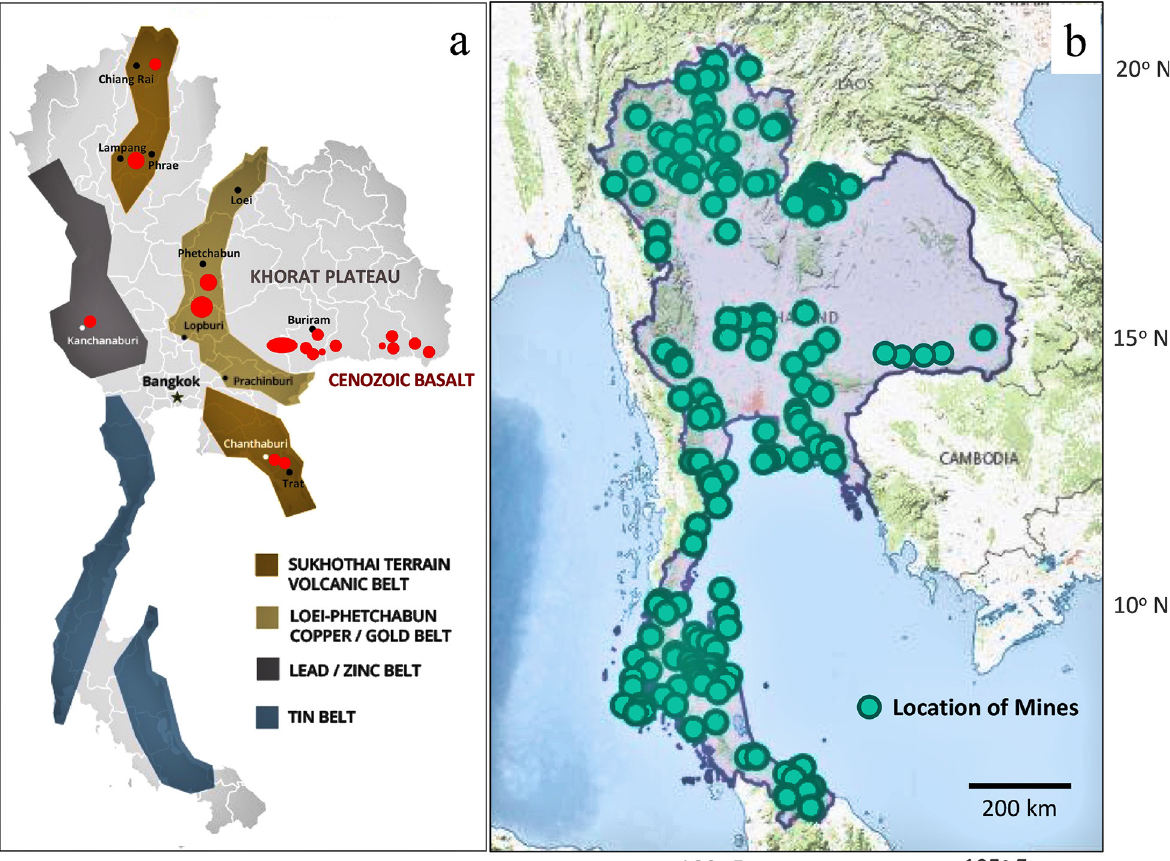
Fig. 1. a – Thai metallogenic belt and b – location of mining in Thailand (modified from The diggings © program and data from USGS